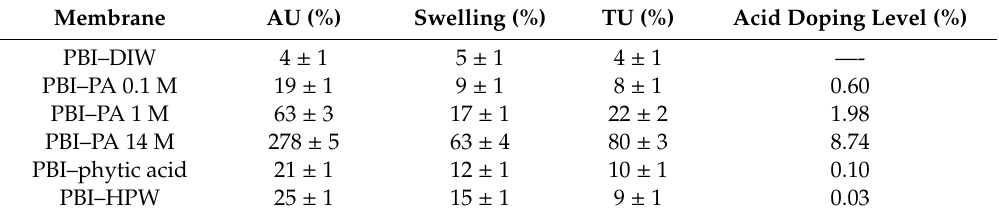
Table 1. Acid uptake (AU), swelling, and thickness uptake (TU) of the PBI membranes doped at room temperature under di ff erent conditions. DIW, deionized